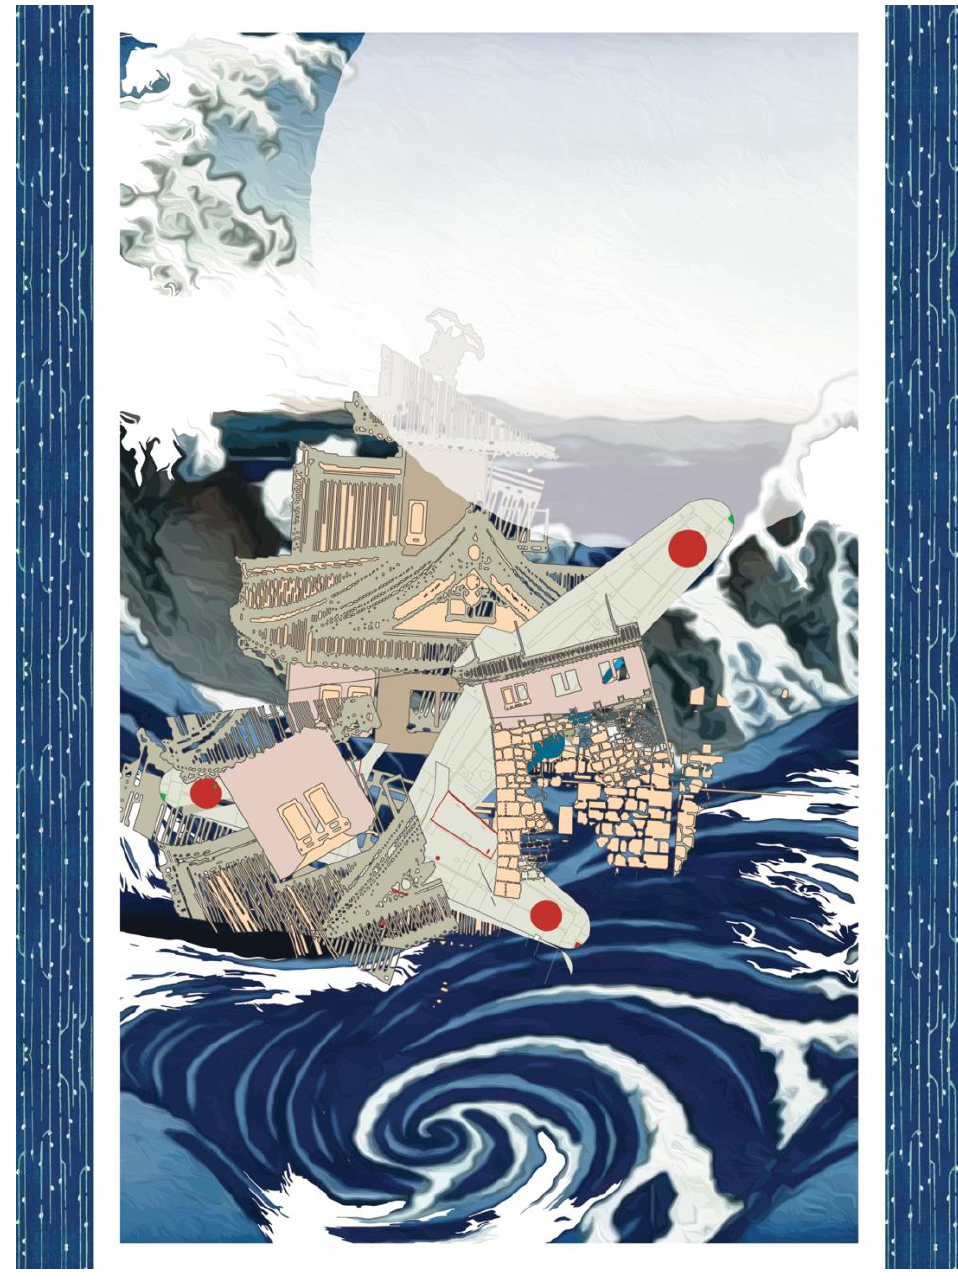
Kio Griffith, Eight Views of the Sun Setting on the South Pacific / Whirlpool Passage , 2021. Digital collage print on